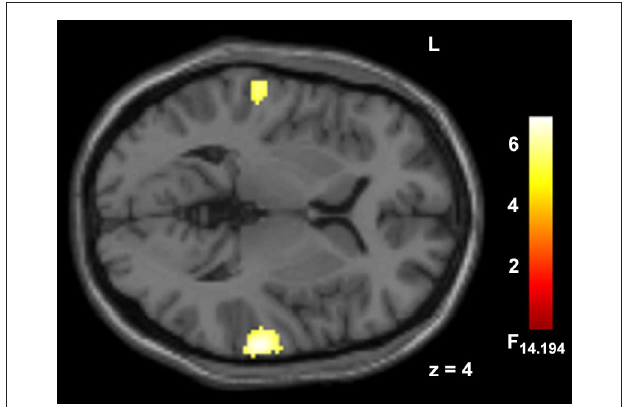
FIGURE 3 | Hemodynamic responses to auditory deviants. Deviant syllables (/ka/) as compared to ongoing standards (/ba/) elicited responses in auditory cortex. Peak voxel MNI coordinates of right AC: [68, − 26, 8] and left AC: [ − 62, − 23, 4]; p < 0.05, FWE corr., extend threshold 5